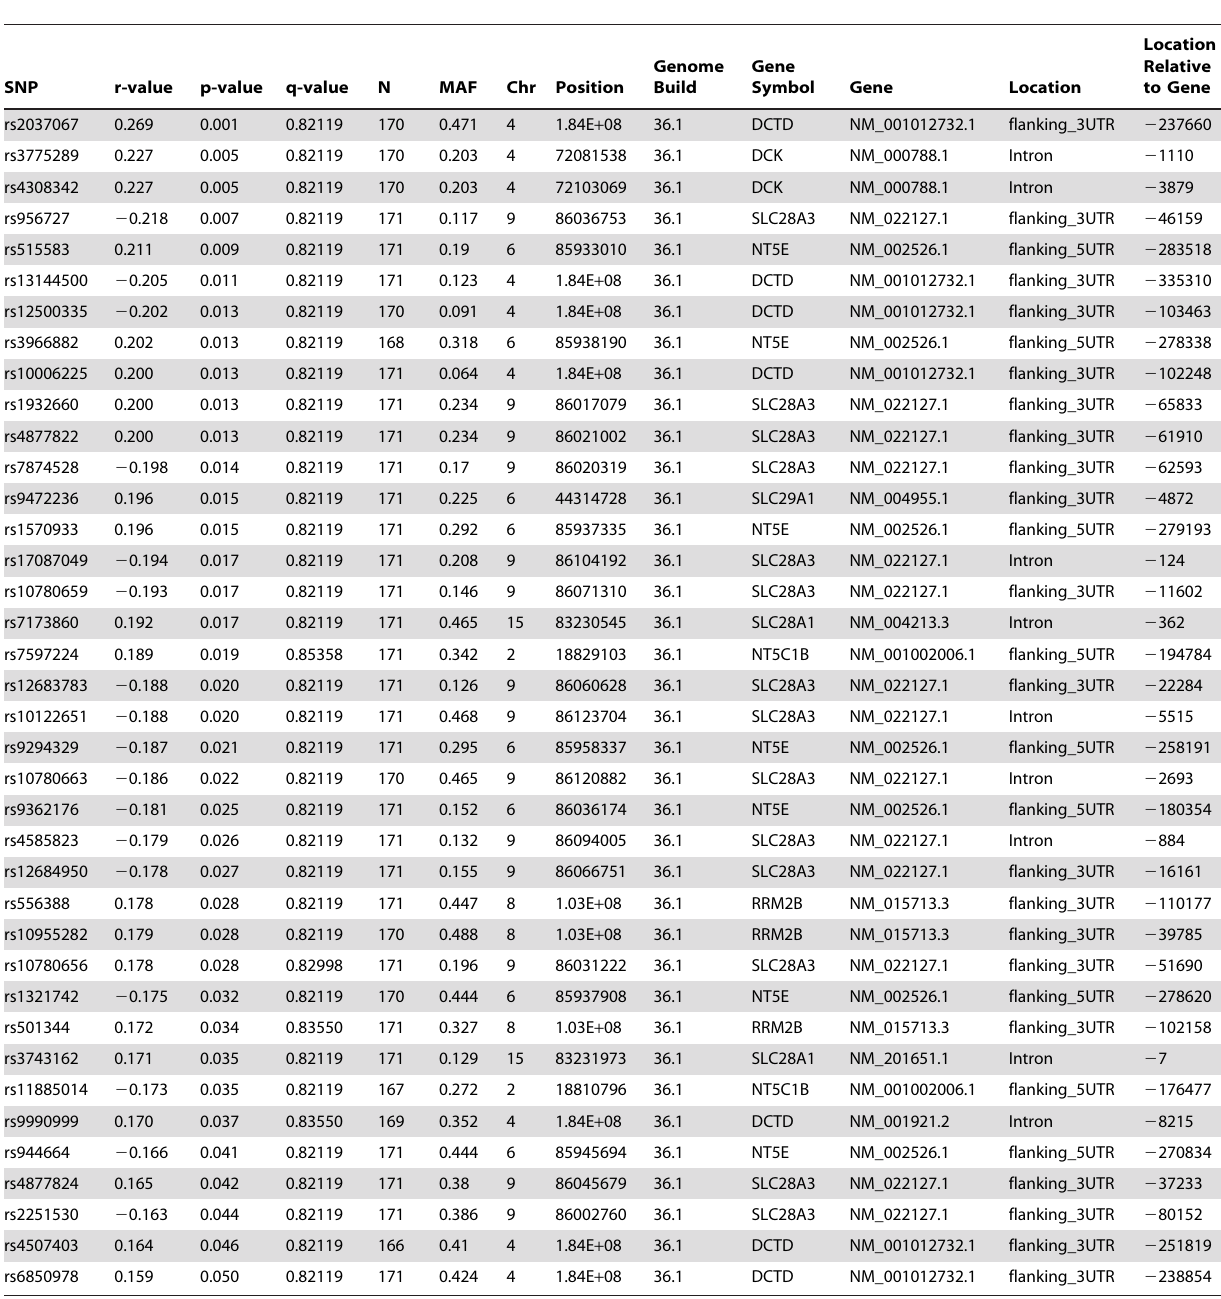
Table 3. Top 38 significant SNPs within or close to 8 pathway genes associated with gemcitabine IC 50 values (p ,